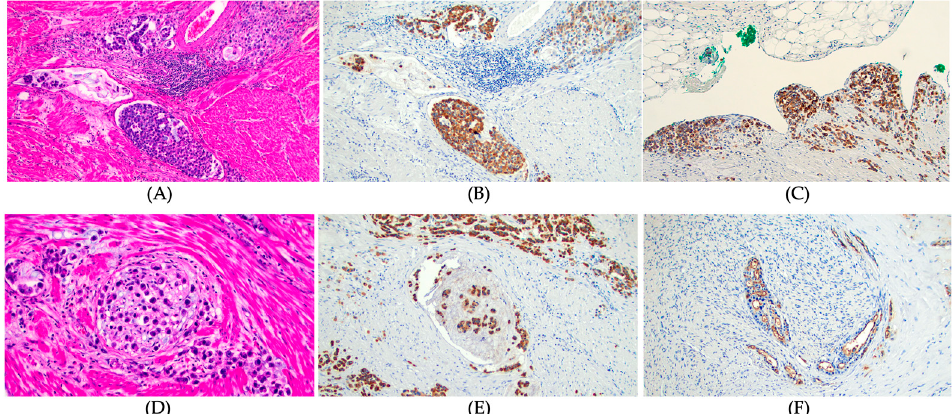
Figure 2. MUC1 expression and pathological features of gastric cancer. ( A ) Lymphovascular invasion, diffuse signet ring cell gastric carcinoma. Hematoxylin and Eosin stain, ×100, ( B ) Strong MUC1 expression in tumors cells invading lymphatics and vessels. MUC 1 IHC, ×100, ( C ) Strong MUC 1 expression in tumor cells infiltrating serosal surface. MUC 1 IHC, ×100, ( D ) Intraneural invasion, diffuse signet ring cell carcinoma. Hematoxylin and Eosin stain, ×200, ( E ) Strong MUC1 expression in tumor cells infiltrating nerve bundle, diffuse signet ring cell carcinoma. MUC 1 IHC, ×100, and ( F ) Strong MUC1 luminal expression in tumor cells infiltrating nerve bundle, intestinal type gastric adenocarcinoma. MUC 1 IHC, ×100. Table 3. MUC1 expression and pathological characteristics of gastric cancer.